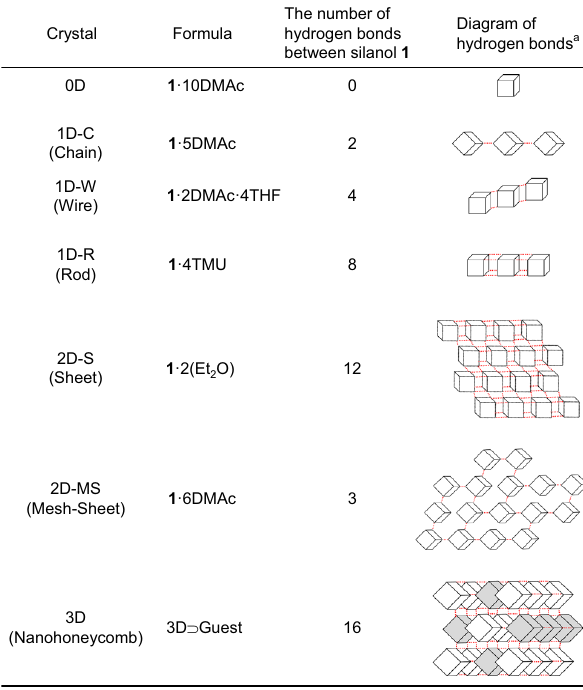
Fig. 3 The summary of the hydrogen-bonding manner of [Si 8 O 12 ][OH] 8 (1). a Cubes and red dashed lines indicate molecules of 1 and hydrogen bonds between silanol groups of 1 ,